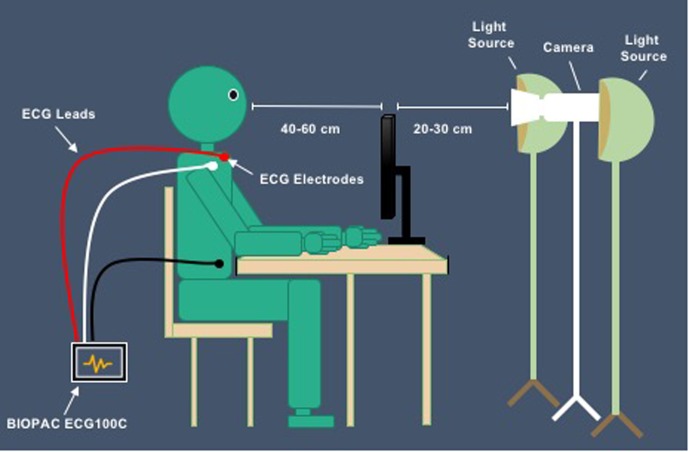
Set up of study.